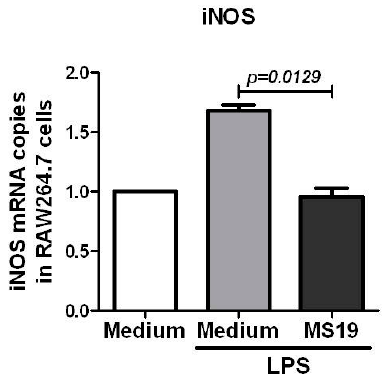
Figure 5. MS19 down-regulated the mRNA Levels of iNOS in LPS-treated RAW264.7 cells. RAW264.7 cells were treated with LPS (1 µg/mL) or LPS (1 µg/mL) + MS19 (8 µg/mL) for 2 h, and then lysed to isolate total RNA for amplifying mRNA by qRT-PCR. GAPDH mRNA level was as normalized standard. The data were representative of three independent experiments.